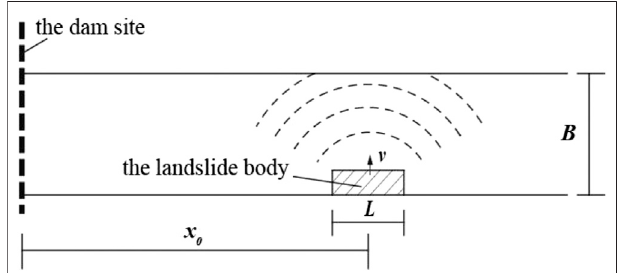
FIGURE 1 | Sketch map of the Pan